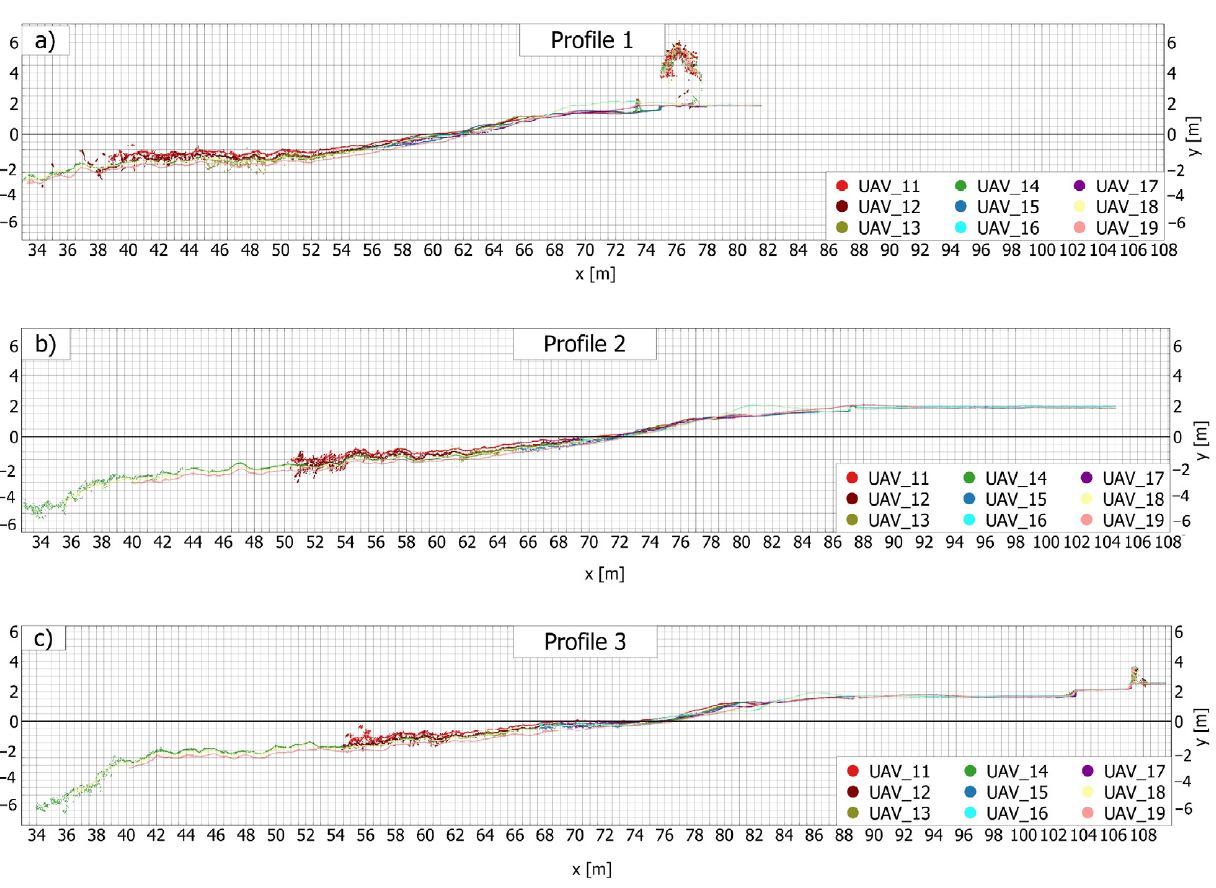
Figure 2. Cross shore profiles selected for the runup analysis; ( a ) the western profile position, which is shown on Figure 1d as profile 1; ( b ) the centerline profile position, which is shown on Figure 1d as profile 2; ( c ) the eastern profile position, which is shown on Figure 1d as profile 3; table showing the nine associated UAV surveys between 1 October 2020 and 26 February 2021 is in Appendix A.